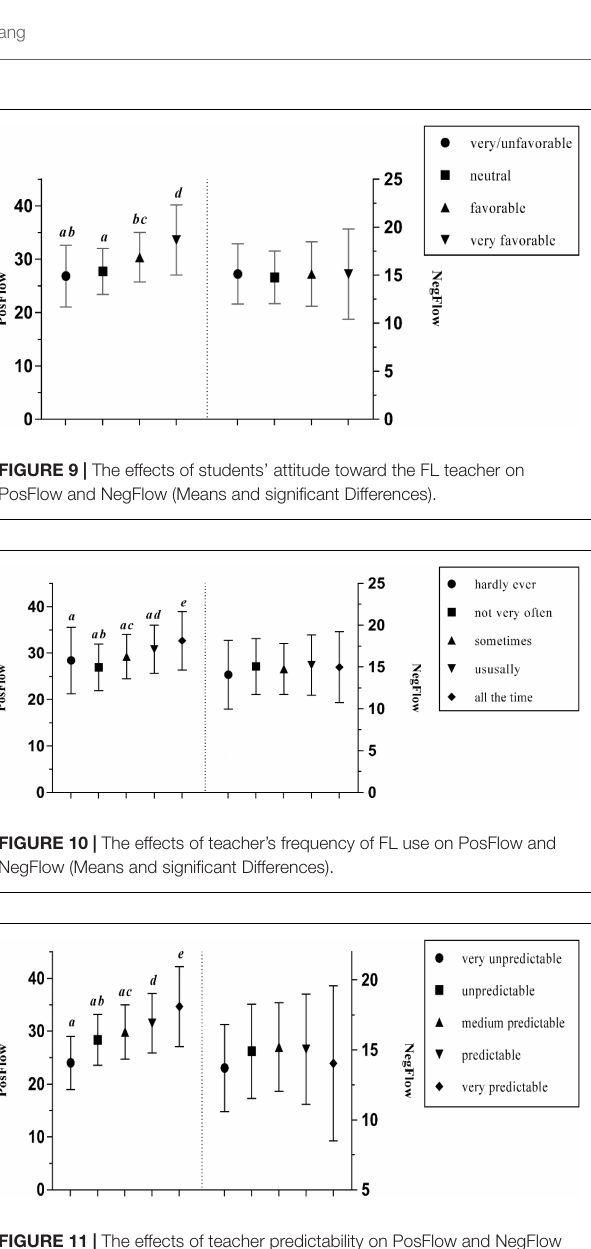
FIGURE 11 | The effects of teacher predictability on PosFlow and NegFlow (Means and Significant